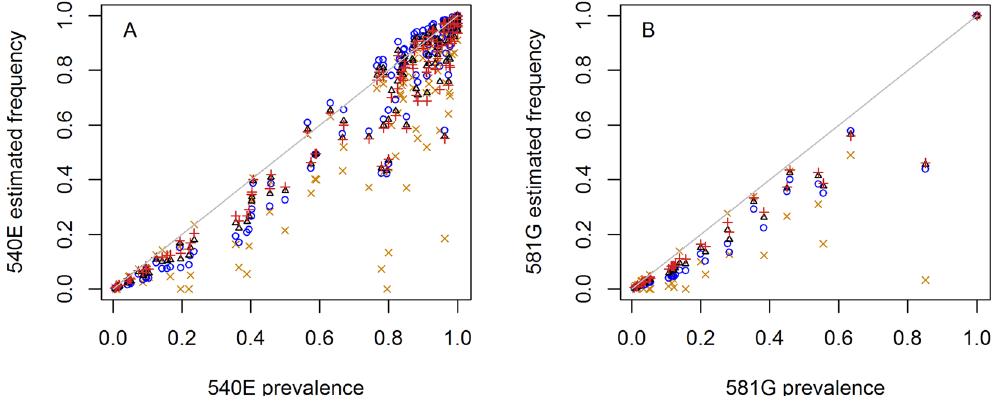
Figure 5. Prevalence of ( A ) 540E and ( B ) 581G mutations in the systematic review data compared with frequencies in the parasite population estimated by different methods: simple counting of mutant samples excluding mixed infections (orange crosses; Method 1A); by assuming 100% detection of clones (blue circles; Method 5A); by assuming detection is independent of MOI (Method 5C) with a probability of detection per clone of 0.54 (black triangles); or 0.3 (red vertical crosses). Surveys were included in these figures if they detected the mutant and reported the prevalence of mixed wild type-resistant